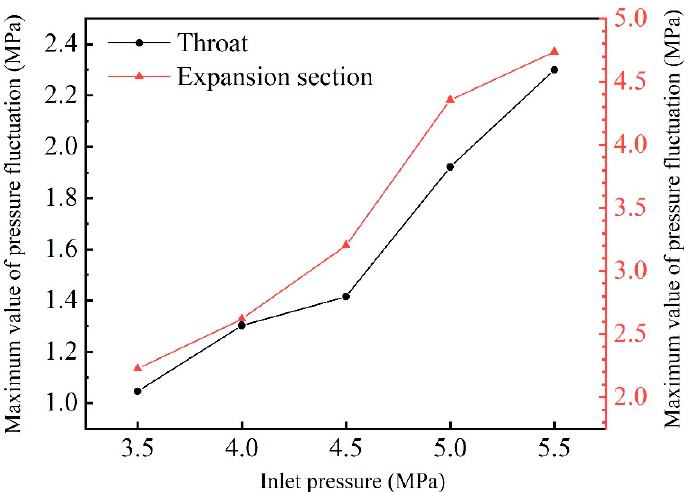
Figure 12. Changes of the maximum pressure at the throat and expansion section under increasing inlet inlet pressures.